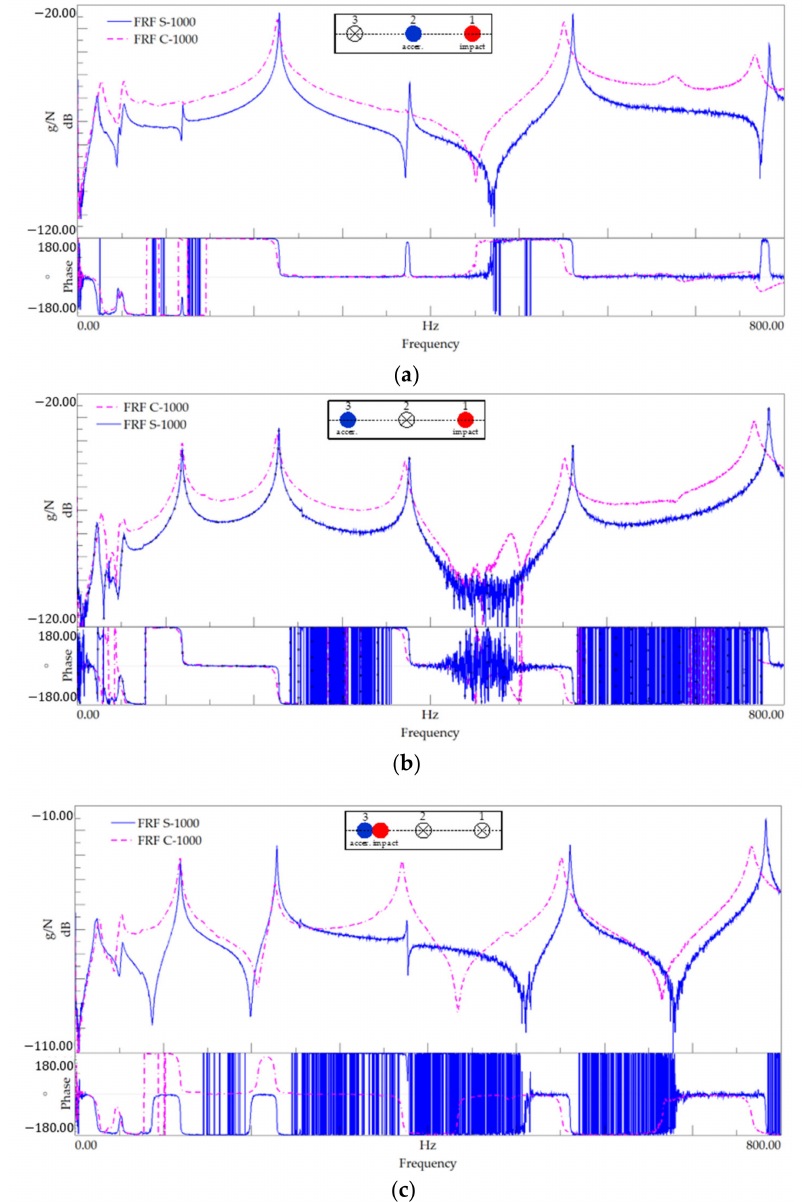
Figure 10. Modal identification for 1000 mm-length specimens—FRF plot for ( a ) setup 1, ( b ) setup 2, and ( c ) setup